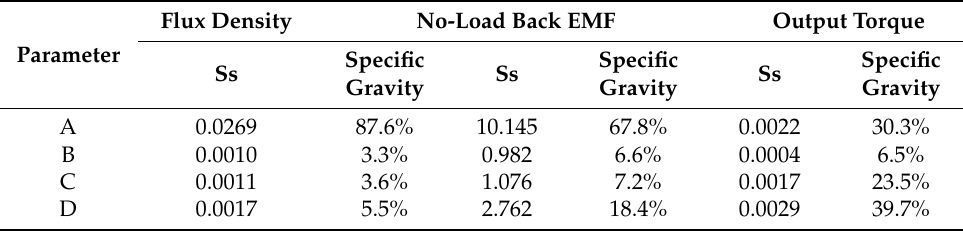
Table 10. Proportion of influence of the parameters on target